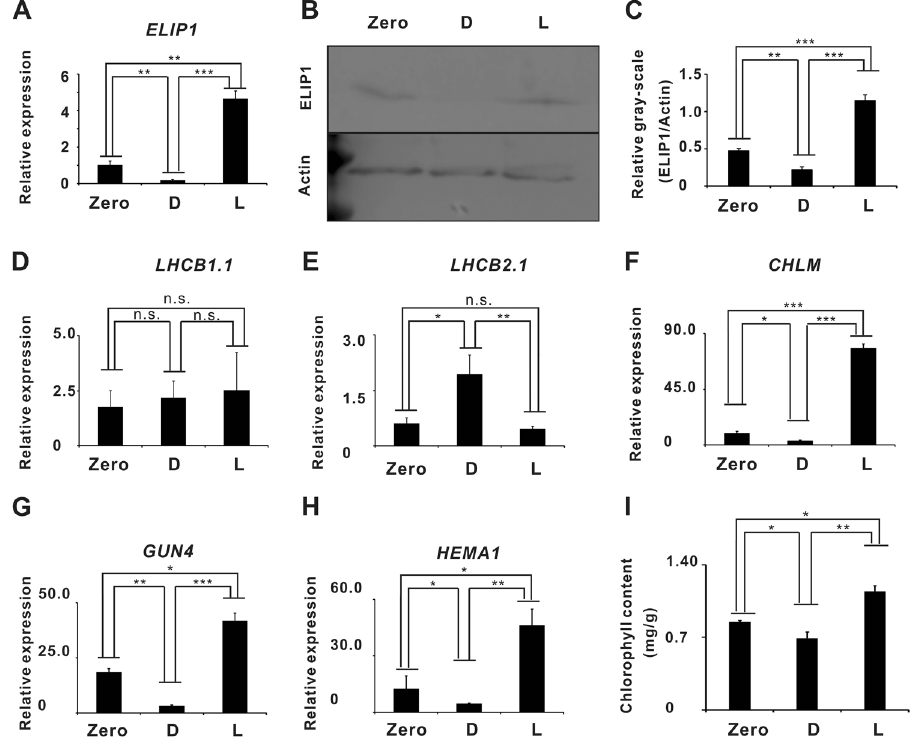
Figure 2. Light regulation experiment. ( A ) ELIP1 expression. ( B ) Western-blot shows that ELIP1 expression was higher in the samples exposed to light but hardly detected the samples stored in the dark. ( C ) Quantitative analysis of Western blot strips by Image J software. Light can promote the expression of ELIP. ( D ) LHCB1.1 expression. ( E ) LHCB2.1 expression. ( F ) CHLM expression. ( G ) GUN4 expression. ( H ) HEMA1 expressions. ( I ) Chlorophyll content. Fresh Chinese cabbage samples were used as the control and marked as Zero, the samples stored under light condition were marked as L, and the samples stored under dark condition were marked as D. Asterisks indicate a significant difference compared to control negative as analyzed by Dunnett, one-way ANOVA. (* p < 0.05; ** p < 0.01; *** p < 0.001). All error bars are expressed as